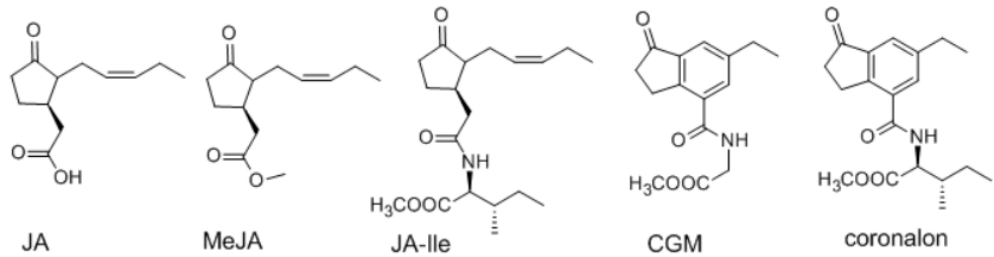
Figure 1. The structures of four jasmonate elicitors used in this research and coronalon (not used here).